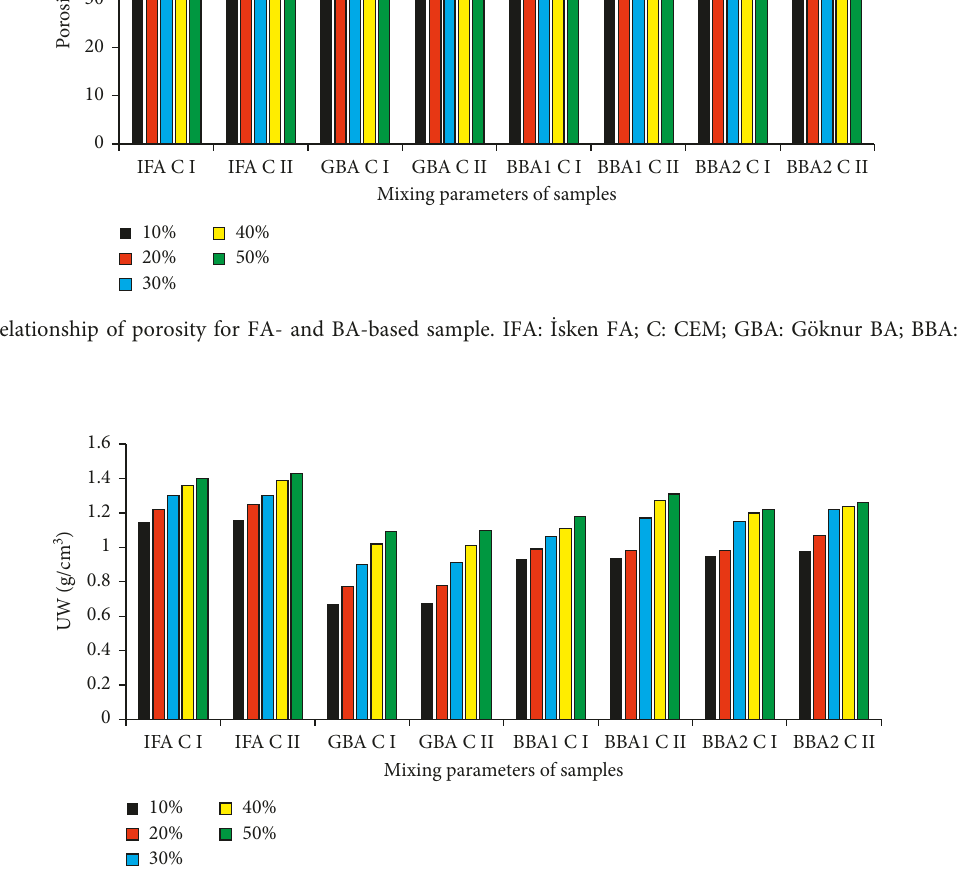
Figure 10: Relationship of UW for FA- and BA-based sample. IFA: ˙Isken FA; C: CEM; GBA: G¨oknur BA; BBA: Bor